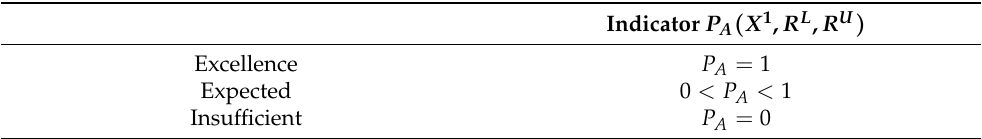
Table 2. Type of academic performance from P A